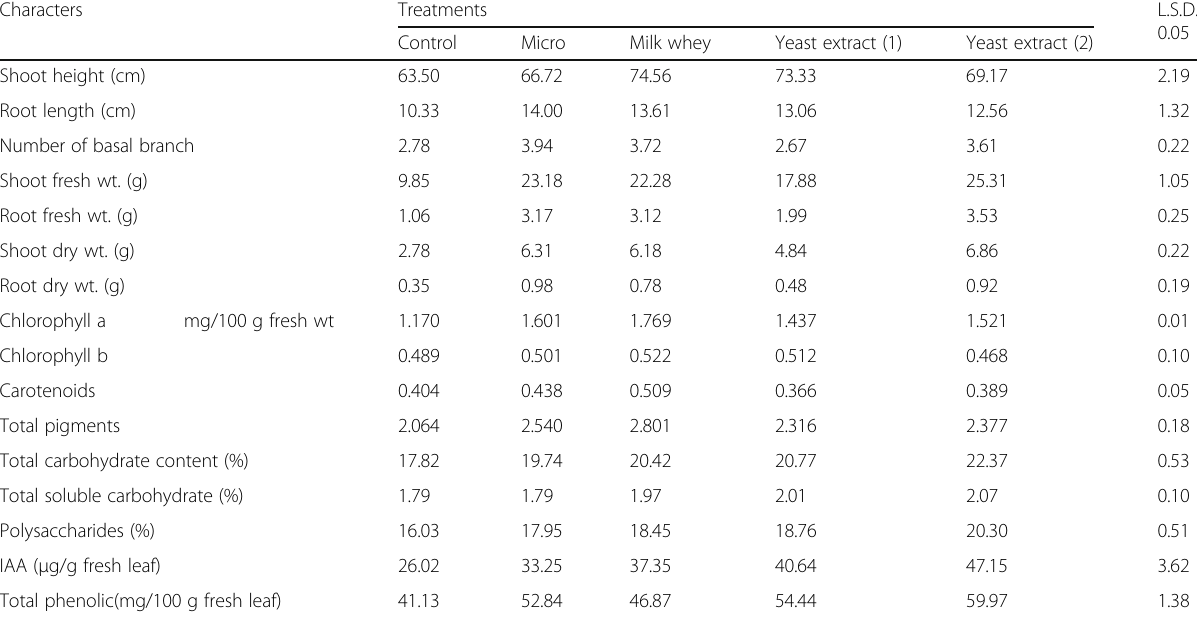
Table 5 Effect of bio-fertilizer treatments on growth parameters and chemical content of flax plants grown under sandy